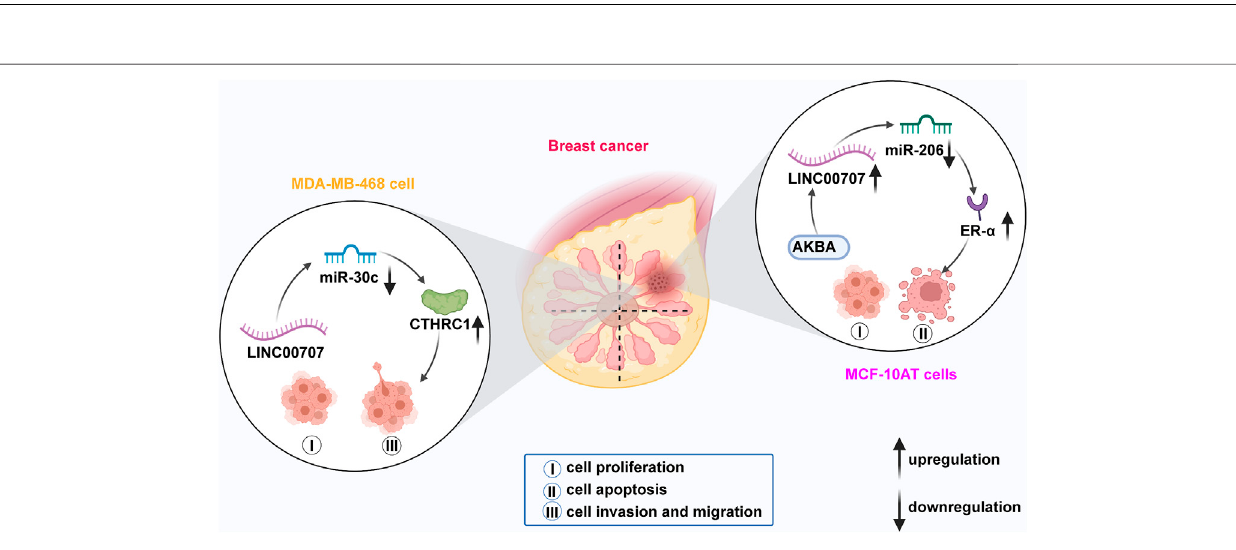
FIGURE2| Inbreastcancer,LINC00707spongesmiR-30ctomodulateexpressionofCTHRC1andthusenhancetheproliferative,invasive,andmigratoryabilities of MDA-MB-468 cells. LINC00707 also interacts with miR-206 to upregulate ER- α expression, which promotes the processes of proliferation and apoptosis of MCF- 10AT